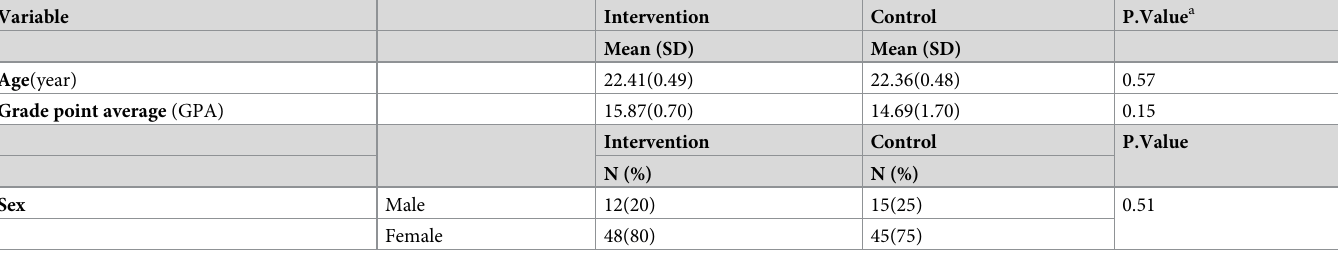
Table 1. Demographic characteristics of participants.